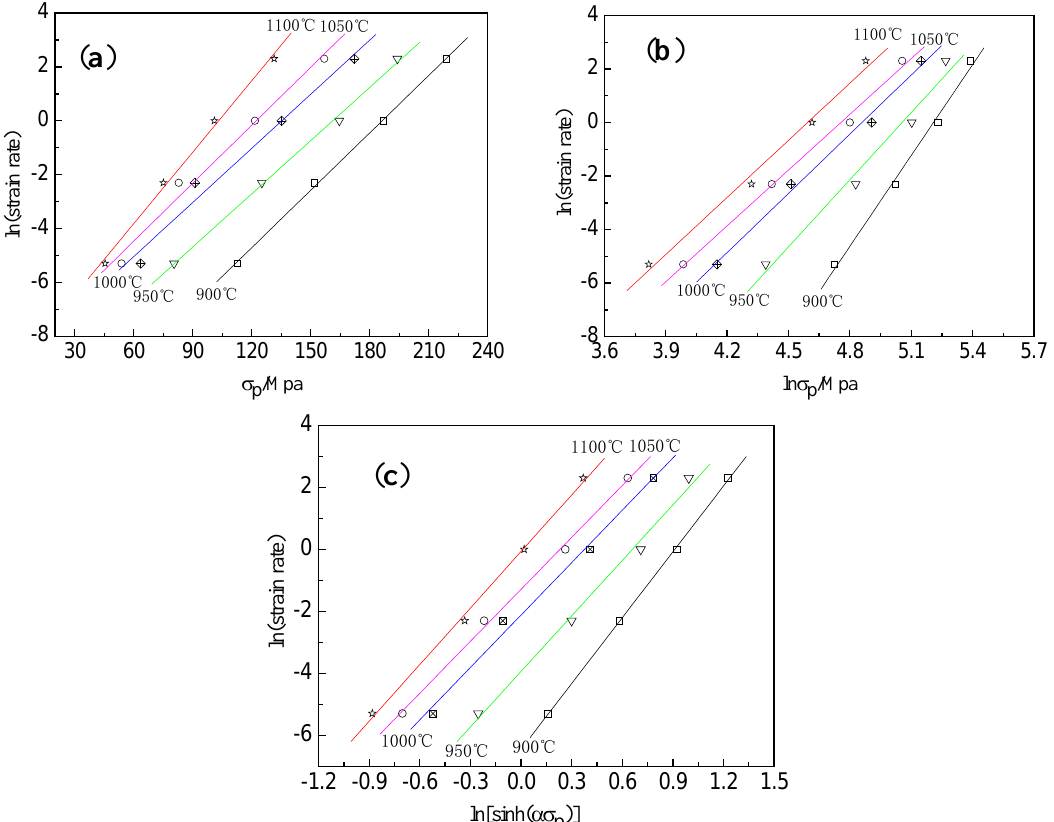
Figure 3. Relations between ( a ) ln(strain rate) and ln σ p , ( b ) ln(strain rate) and σ p , and ( c ) ln(strain rate) and ln[sinh( ασ p )] at different temperatures.